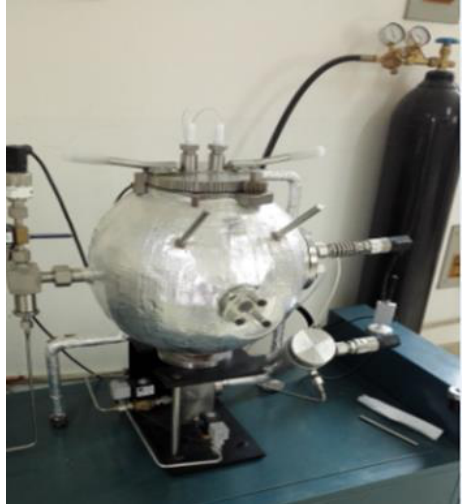
Figure 4. A 20 L, HY16426C ball-type dust explosion parameter testing device.